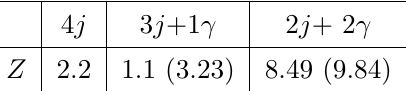
Table 5 . Comparison of signal sensitivities for the BP0 between di(cid:11)erent channels. The numbers are quoted for 35 fb (cid:0) 1 of integrated luminosity. The number in bracket for the photon mode corresponds to bin-wise estimation of the signal sensitivity. See text for